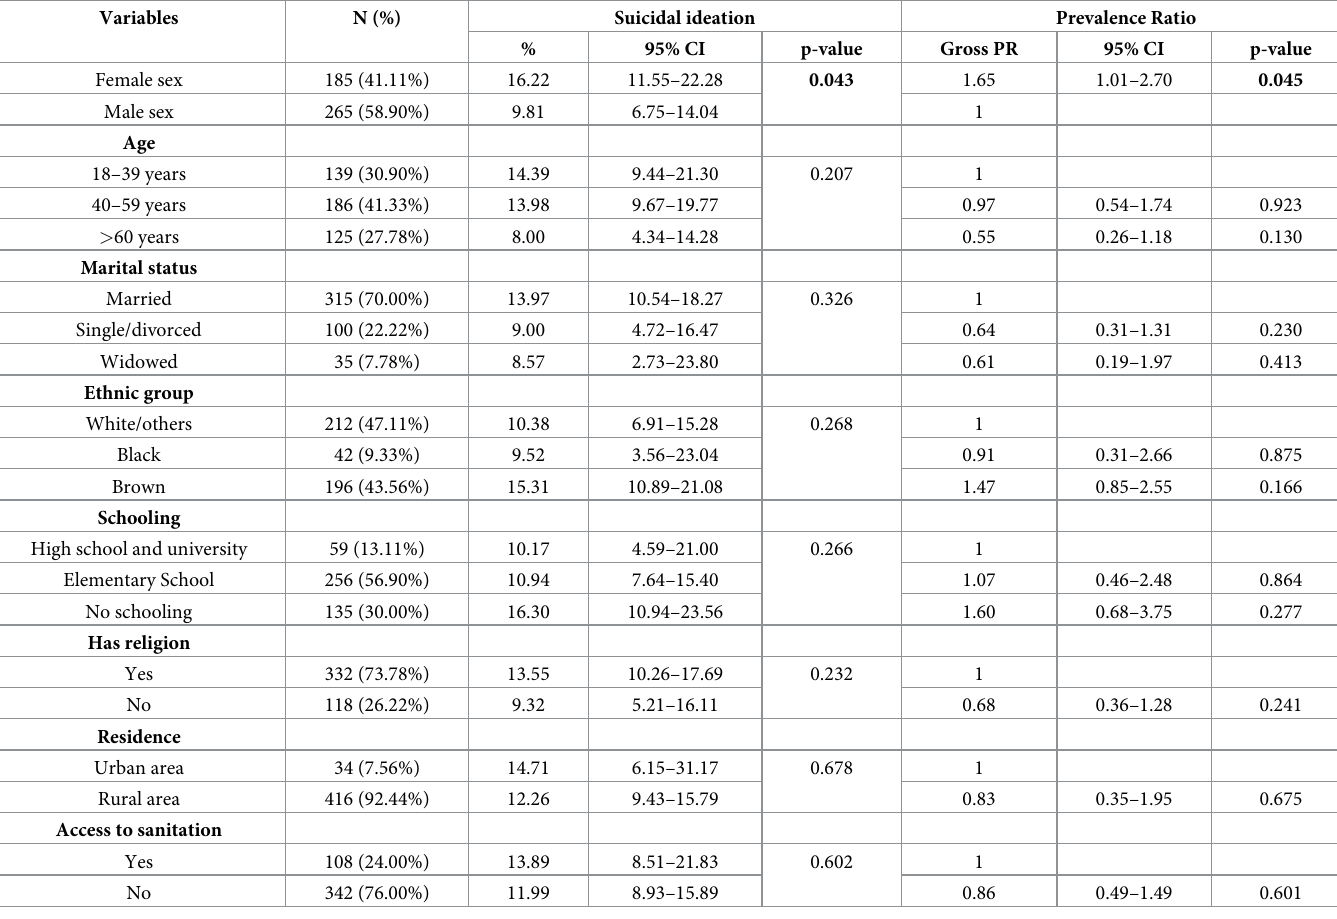
Table 1. Descriptive and bivariate analysis of suicidal ideation and its association with sociodemographic variables of farmers in the city of Caico´-RN.